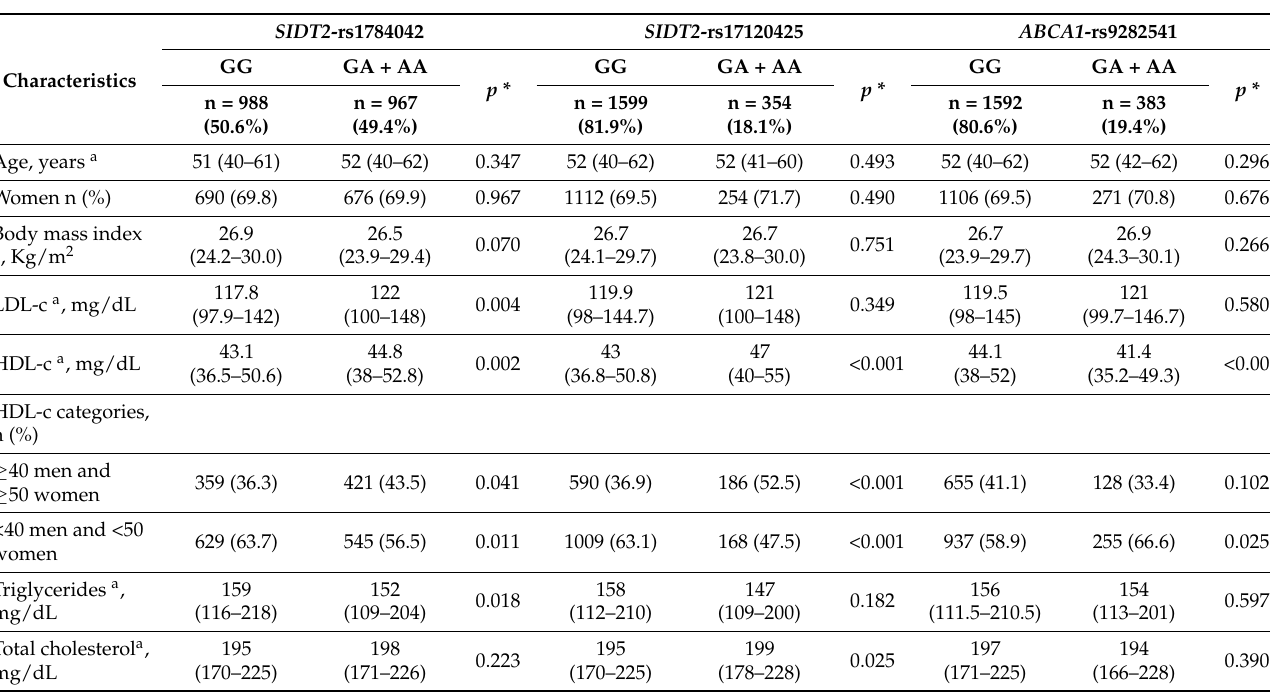
Table 2. Characteristics of the study population categorized by